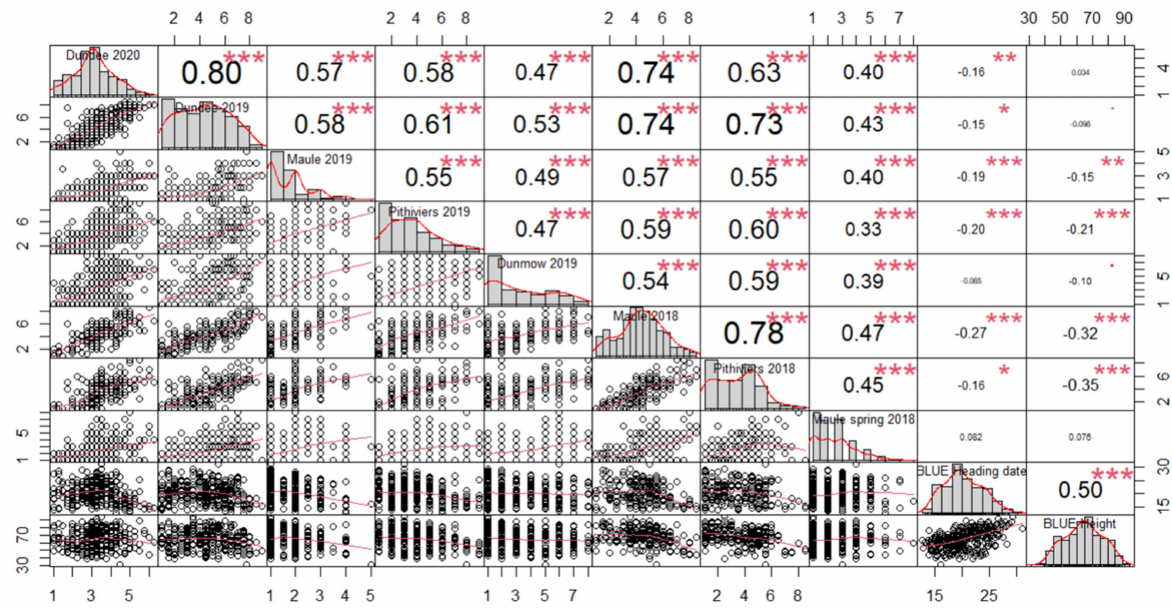
Figure 4. Pearson correlation table between the rhynchosporium phenotypes of the eight field trials, and the best linear unbiased estimator for heading date and height (upper triangle). p -values are indicated with red stars where: * = p -value < 0.05, ** = p -value < 0.01, and *** = p -value < 0.001. The names of the phenotypes are written diagonally, and the phenotypes are plotted depending on each other in the lower